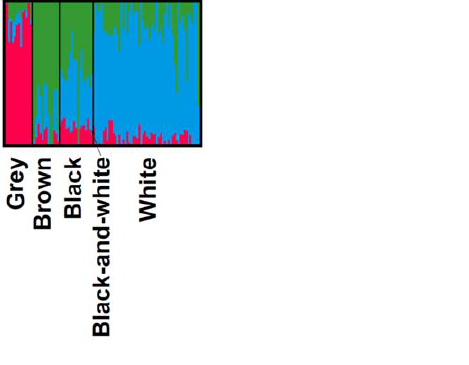
Figure 2. Model-based clustering of 99 Finnsheep where 3 genetic subpopulations or subclusters ( K ) were inferred. Individuals are represented in group of animals in different colours separated by vertical black lines. Each animal is represented by a single vertical line, divided into K colours, where K is the number of clusters estimated, and the coloured segment shows the individual’s estimated proportion of membership to that cluster. The group of animals in different colours are given below the box